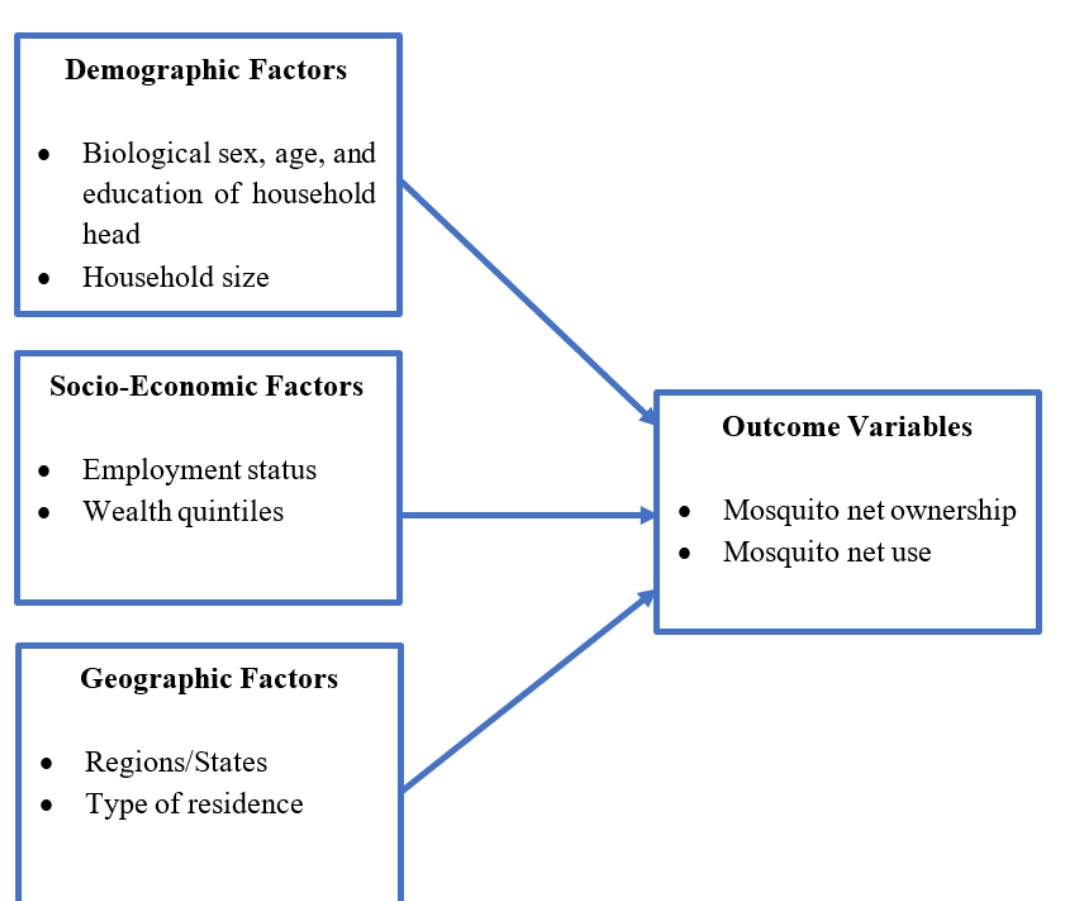
Figure 1. A conceptual model on the potential relationship among key variables.